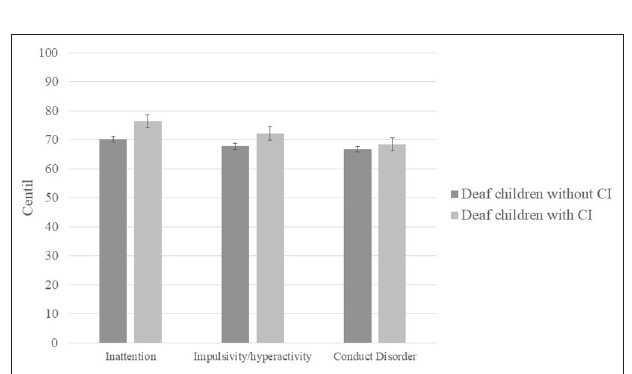
FIGURE 2 | Mean centile scores obtained by deaf children with and without CI in each of the EDAH sub-scales.